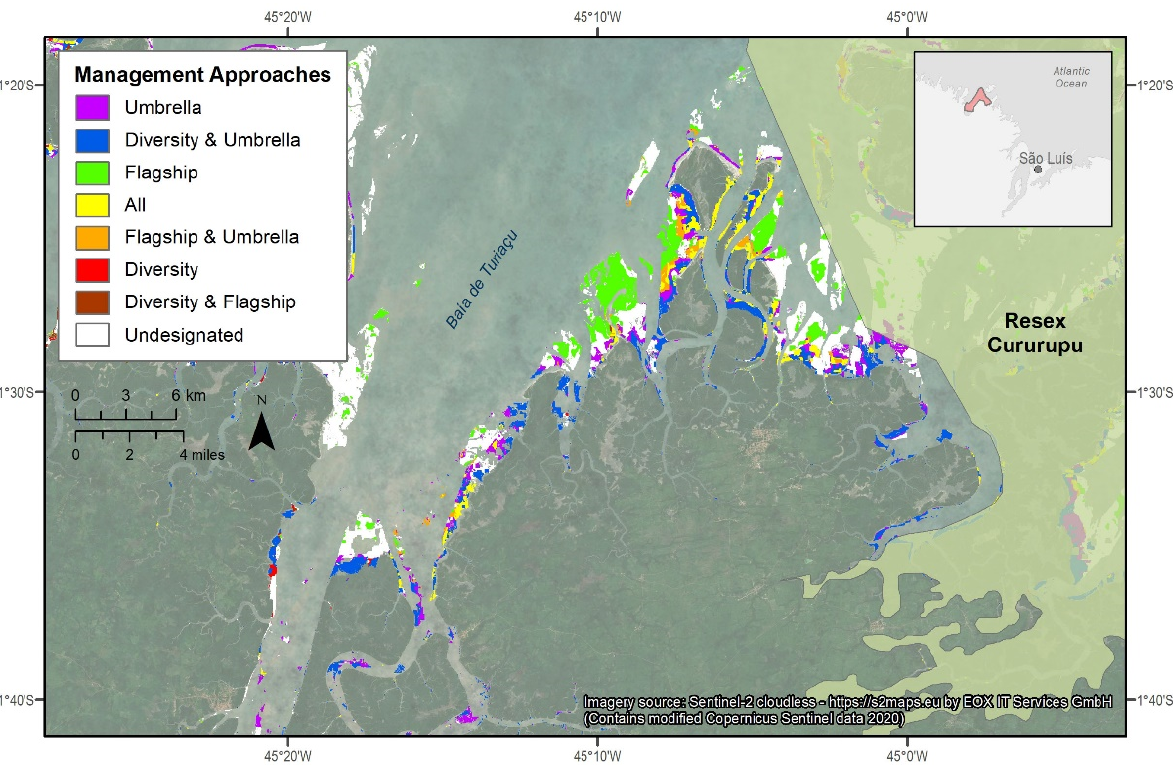
Figure 5. The area adjacent to the existing marine extractive reserve, Resex Cururupu shown as an example of a potential shorebird conservation zone. An inset map in the bottom right shows approximate location of the conservation zone and Resex Cururupu northeast of the state capital of Maranh ã o, S ã o Lu í s. Imagery Source: Copernicus Sentinel 2 cloudless mosaic https://s2maps.eu by EOX IT services GmbH.